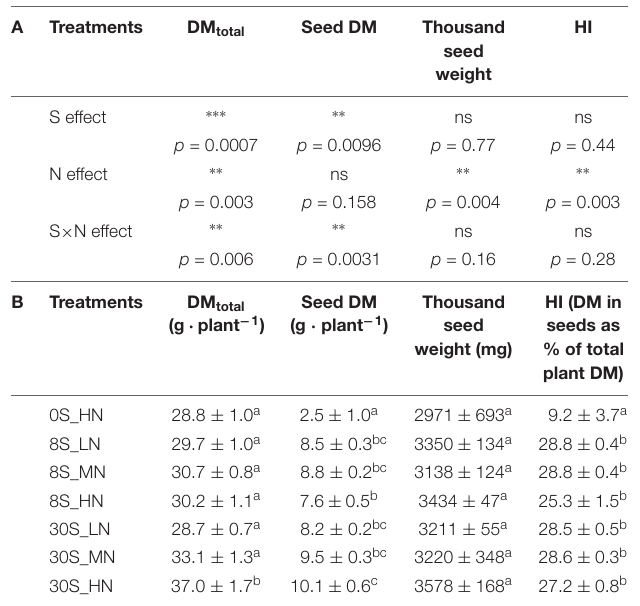
TABLE 1 | S, N, and S × N effects on total DM, seed DM, thousand seed weight, and HI (A) and total DM (g plant − 1 ), seed DM (g plant − 1 ), thousand seed weight (mg), and HI (DM in seeds as % of total DM in plant) for plants grown under 0S_HN, 8S_LN, 8S_MN, 8S_HN, 30S_LN, 30S_MN, and 30S_HN conditions (B) .